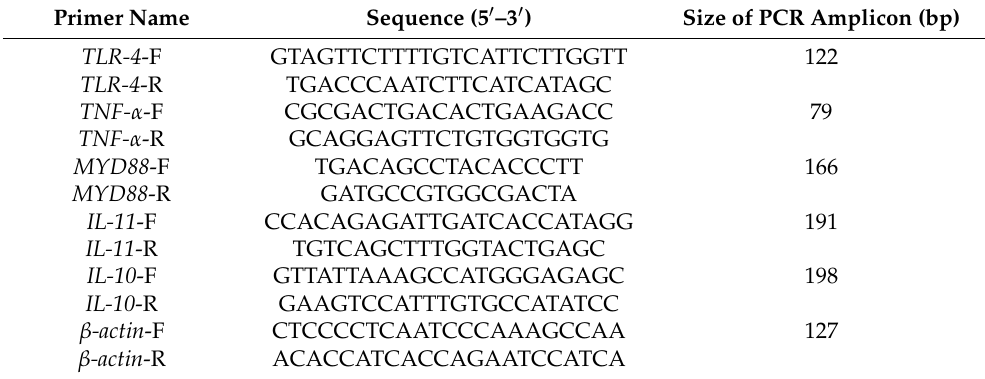
Table 2. Primer sequences for